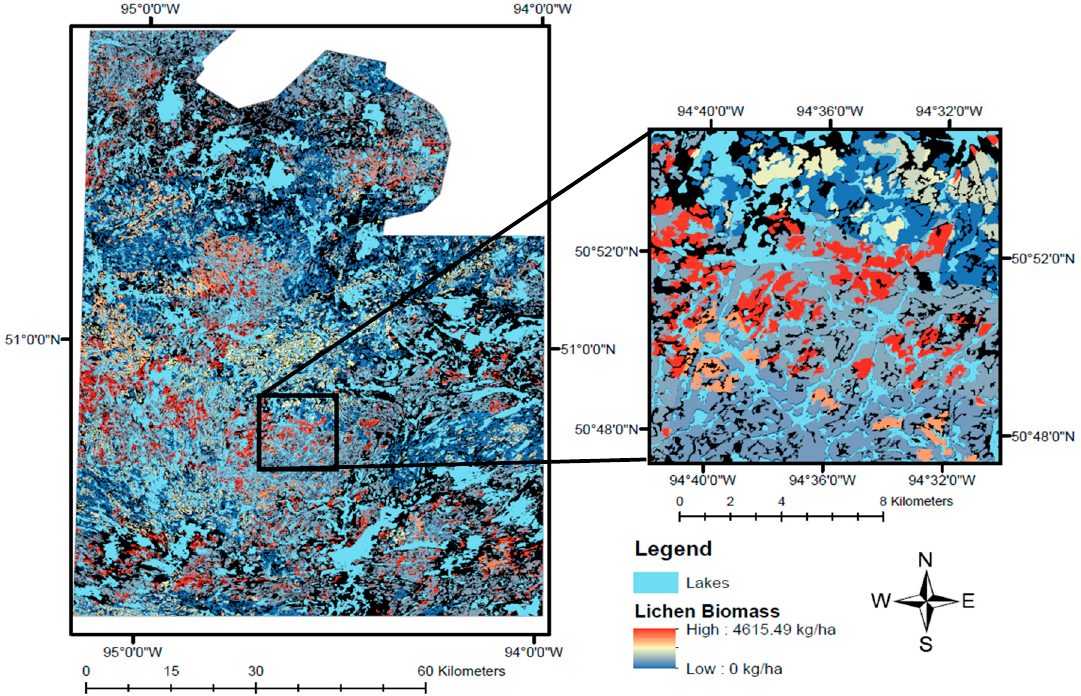
Figure 7. The lichen biomass raster generated for Woodland Caribou Provincial Park, Ontario, Canada. The left panel of the figure shows the entire extent, the right panel shows a close-up of the area around Mexican Hat Lake in the southeast corner of Woodland Caribou Provincial Park. Pixel values represent lichen biomass (kg/ha) from low (blue) to high (red) in dense conifer and sparse conifer ecosites. Lakes appear in light blue. Unsampled ecosites (NoData; Appendix C) are coloured black.